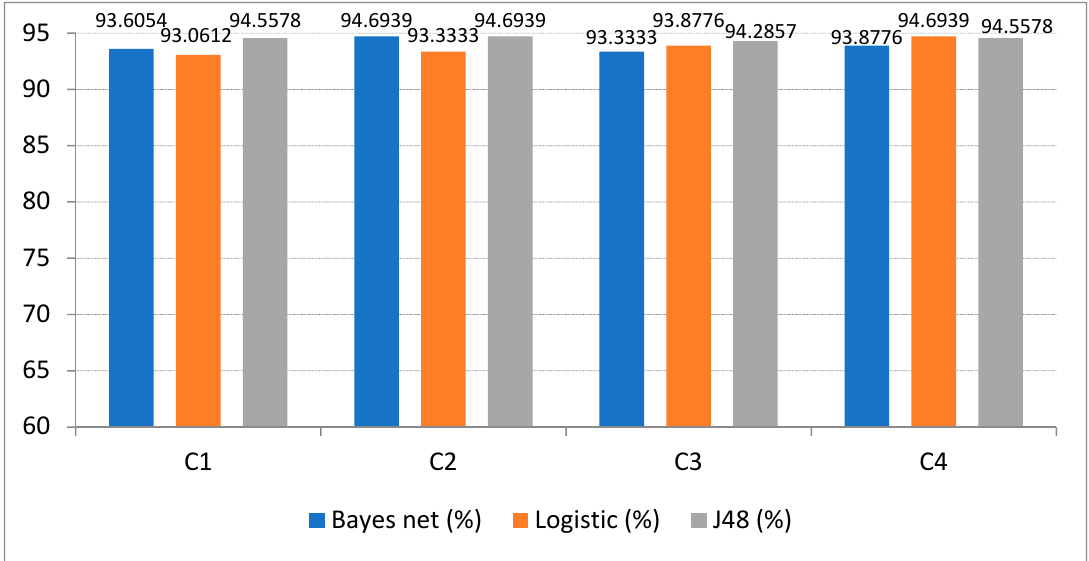
Figure 7. Models C1-C4 new store selection decision (statistical graph). Results of Experiment 3: